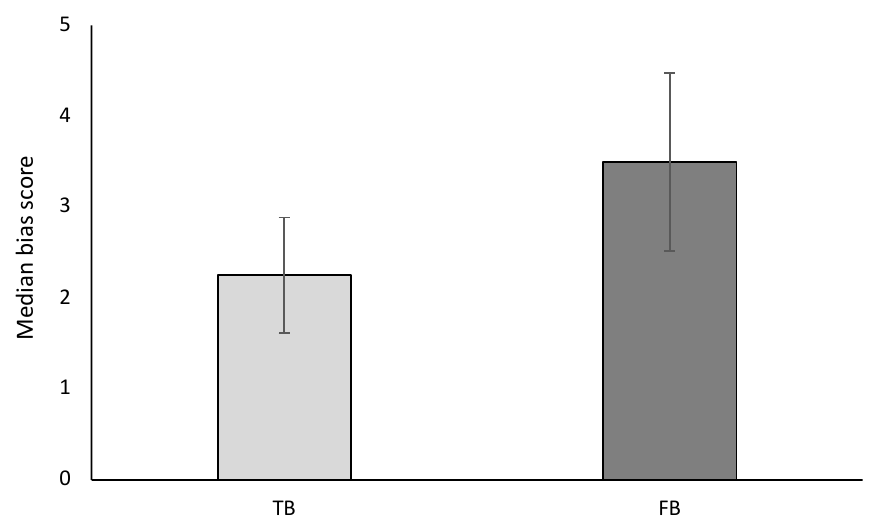
Continuous Search Bias Results for Experiment